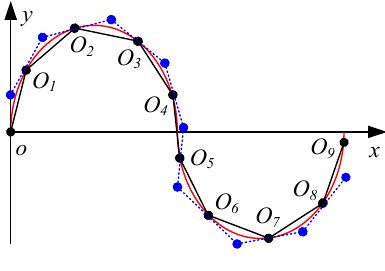
Figure 3. Ideal joint point distribution.